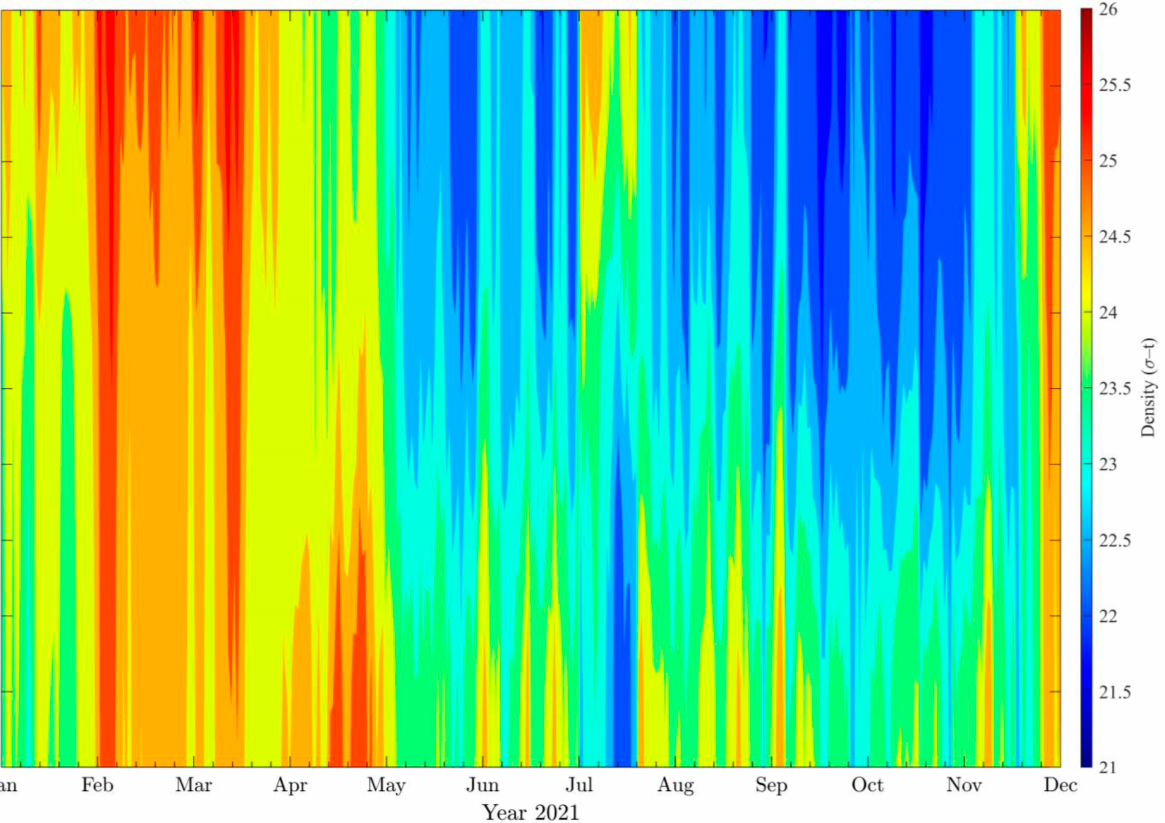
Figure 14. Density profile from January to December 2021 from RMA10 3D model result.